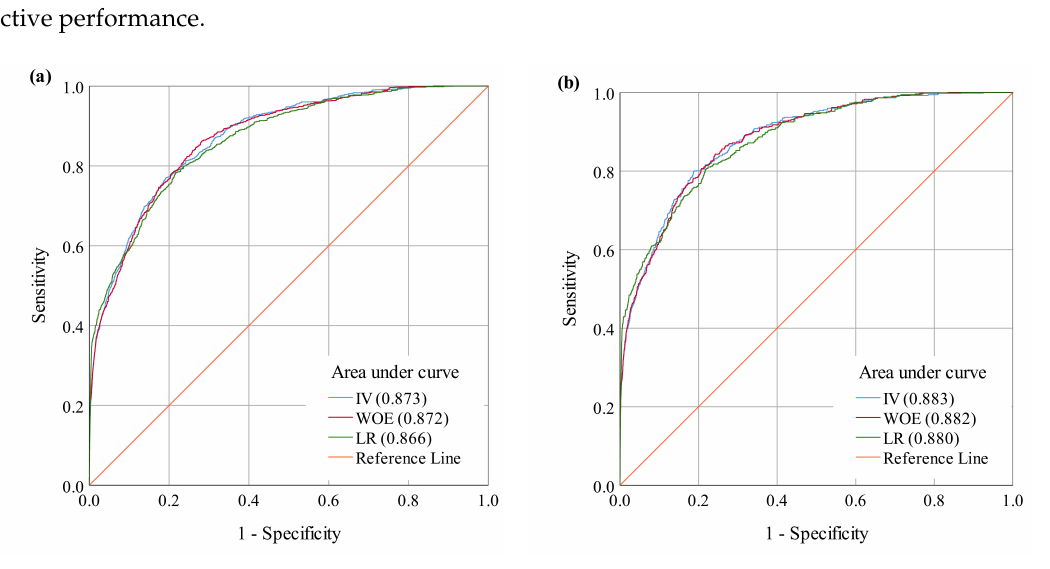
Figure 8. Receiver operating characteristic (ROC) area under the curve (AUC) for ( a ) success rate of the sample and ( b ) prediction rate of the control